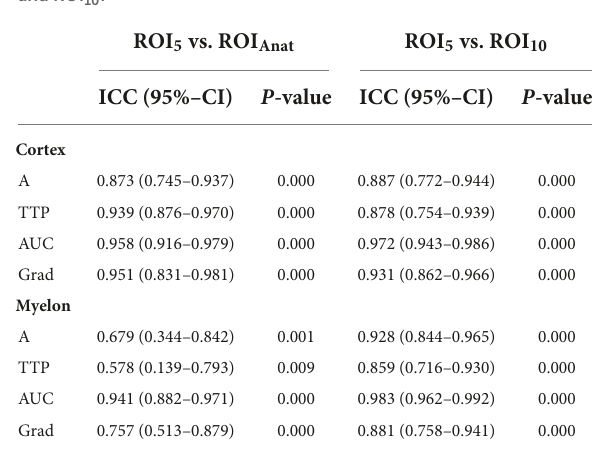
TABLE 3 Intraclass correlation of ROI 5 and ROI Anat and ROI 5 and ROI 10 .